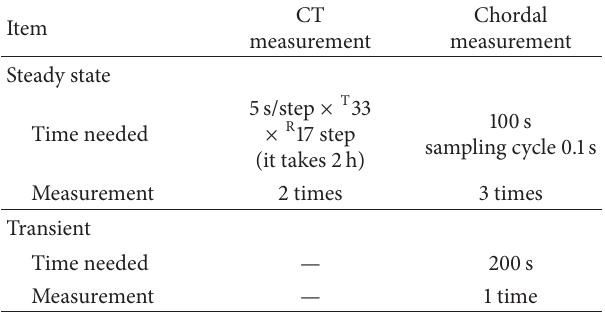
Table 12: Time required to perform void fraction measurements.